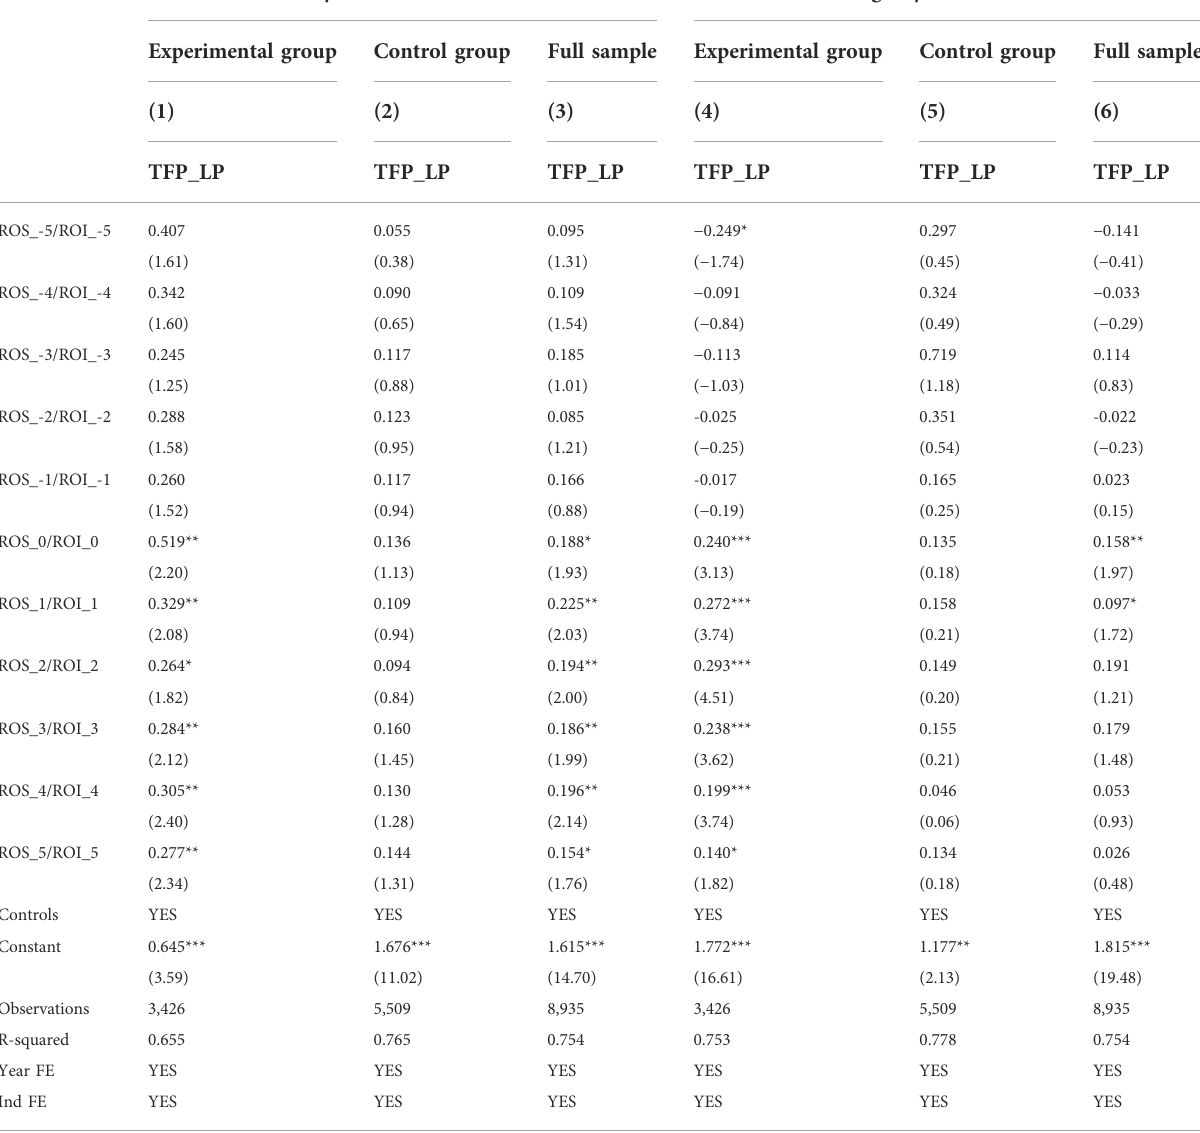
TABLE 6 The dynamic effects of tax enforcement